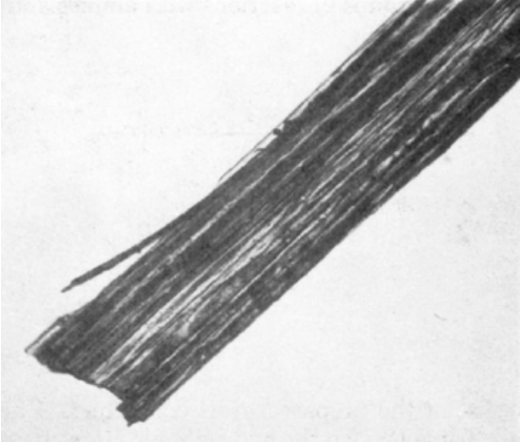
Figure 5. Oriented crystalline structure formed when the poly(decamethylene phosphate) sample was drawn from the melt. Reprinted with permission from [23]. Copyright (1993) American Chemical Society.